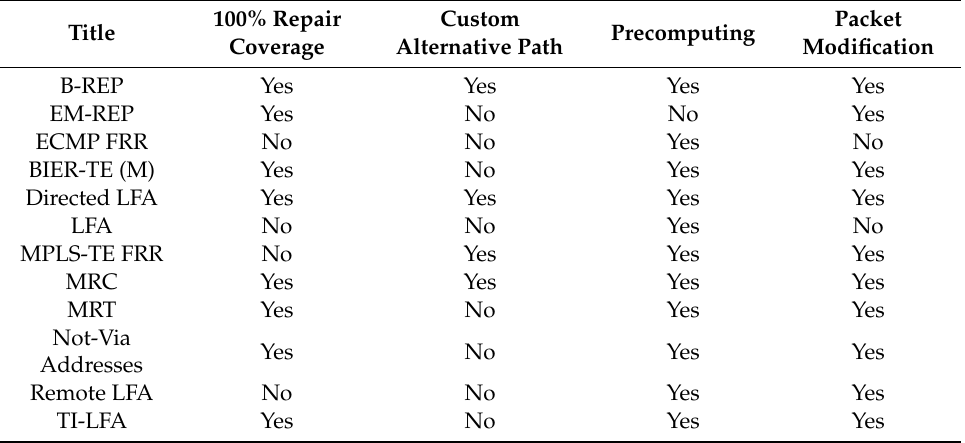
Table 8. Comparison of the B-REP mechanism with existing